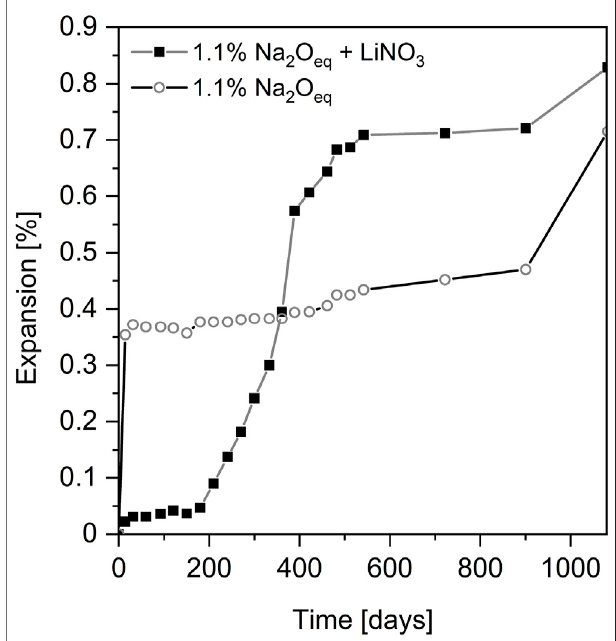
FIGURE7| MortarbarexpansiondeterminedaccordingtoASTMC227. Data from (Zapa ł a-S ł aweta and Owsiak,